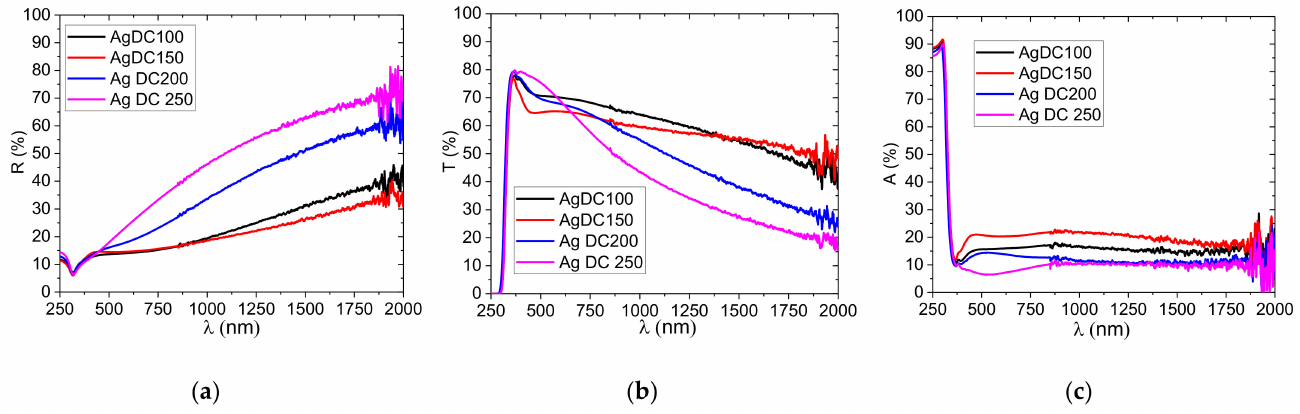
Figure 4. Spectrophotometric curves, ( a ) reflectivity, ( b ) transmittance and ( c ) absorbance of Ag thin films deposited at different DC powers, from 100 to 250